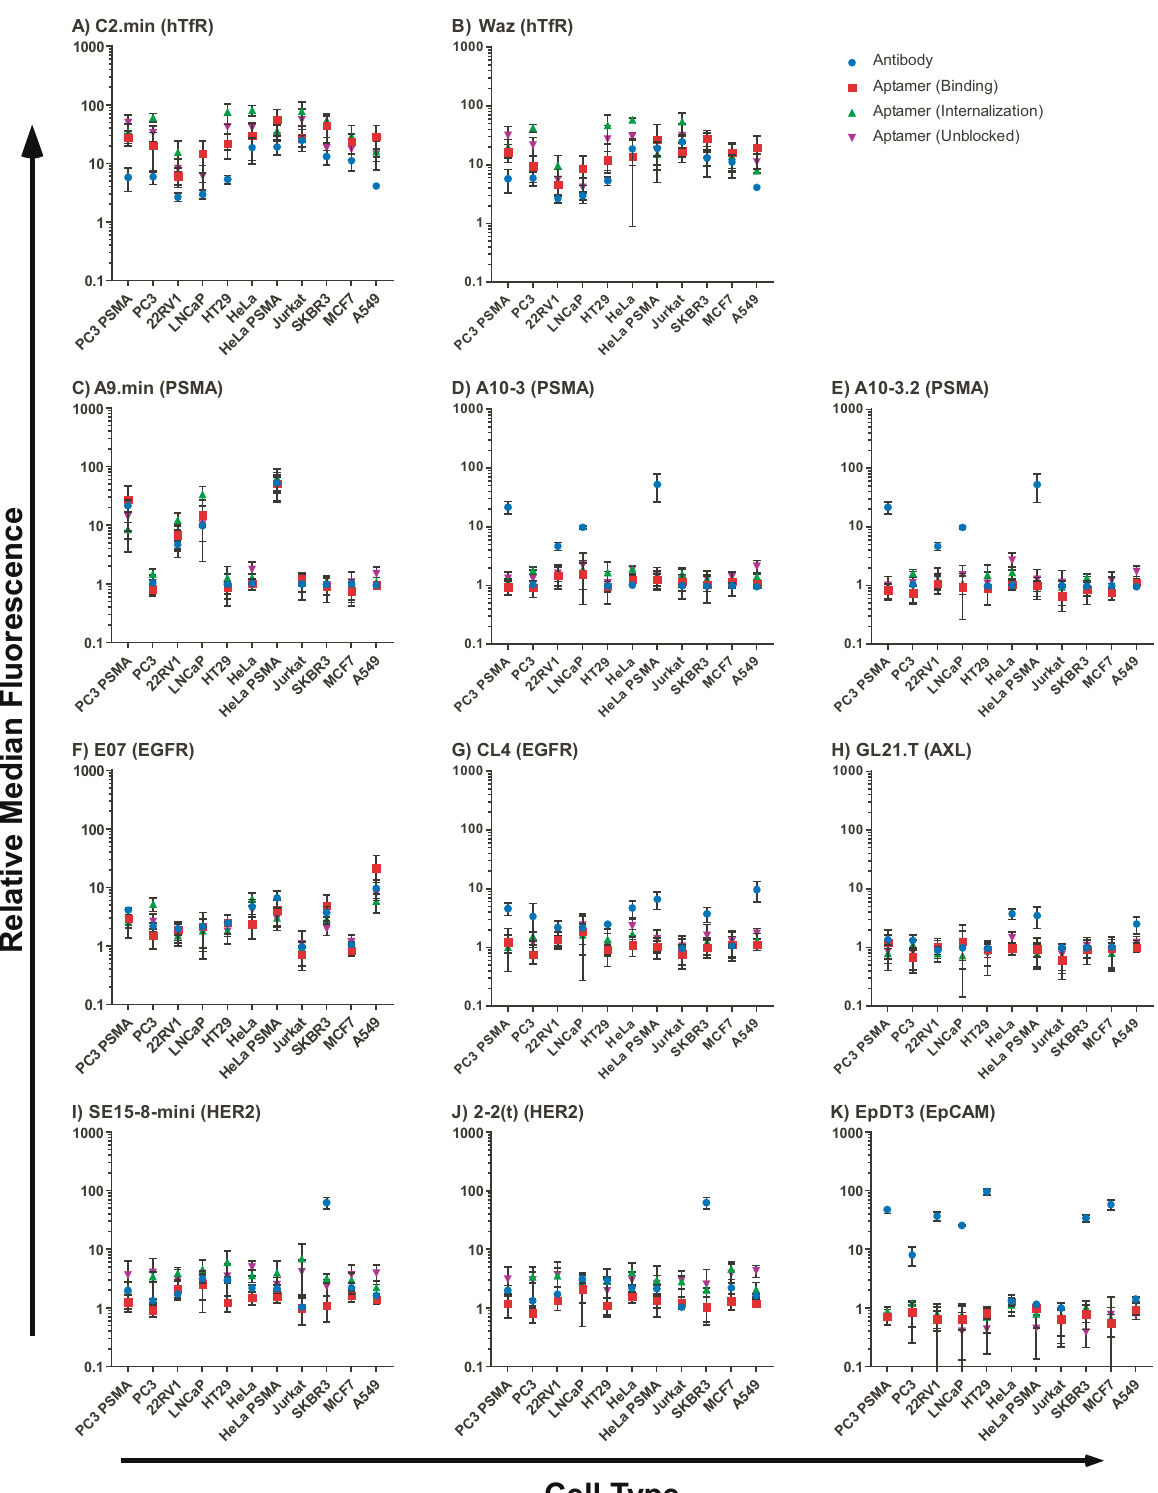
Fig. 3 Correlation of aptamer and antibody binding. The median fl uorescence staining of all aptamers at 500 nM are shown relative to the median fl uorescence of C36 for each cell type. Each aptamer is compared to a commercially available antibody against the aptamer ’ s reported target using either the binding (red) incubated at room temperature or internalization and binding with blocking (green) protocol incubated at 37 °C or internalization and binding without blocking (purple) incubated at 37 °C. Antibody signals are shown relative to an isotype control on each cell line (blue). Aptamers A C2.min and B Waz compared to hTfR antibody. Aptamers C A9.min, D A10-3, and E A10-3.2 compared to PSMA antibody. Aptamers F E07 and G CL4 compared to EGFR antibody. Aptamer H GL21.T compared to AXL antibody. Aptamers I SE15-8-mini and J 2-2(t) compared to HER2 antibody. Aptamer K EpDT3 compared to EpCAM antibody. Data represent the mean of three independent experimental replicates for antibodies and four independent experimental replicates for aptamers ±SD. Source data are provided as a Source Data fi